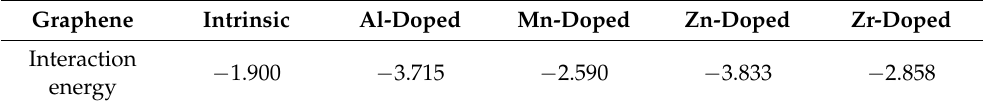
Table 4. Interaction energy between the Mg and the graphene sheets (unit: eV). Graphene Intrinsic Al-Doped Mn-Doped Zn-Doped Zr-Doped Interaction − 1.900 − energy